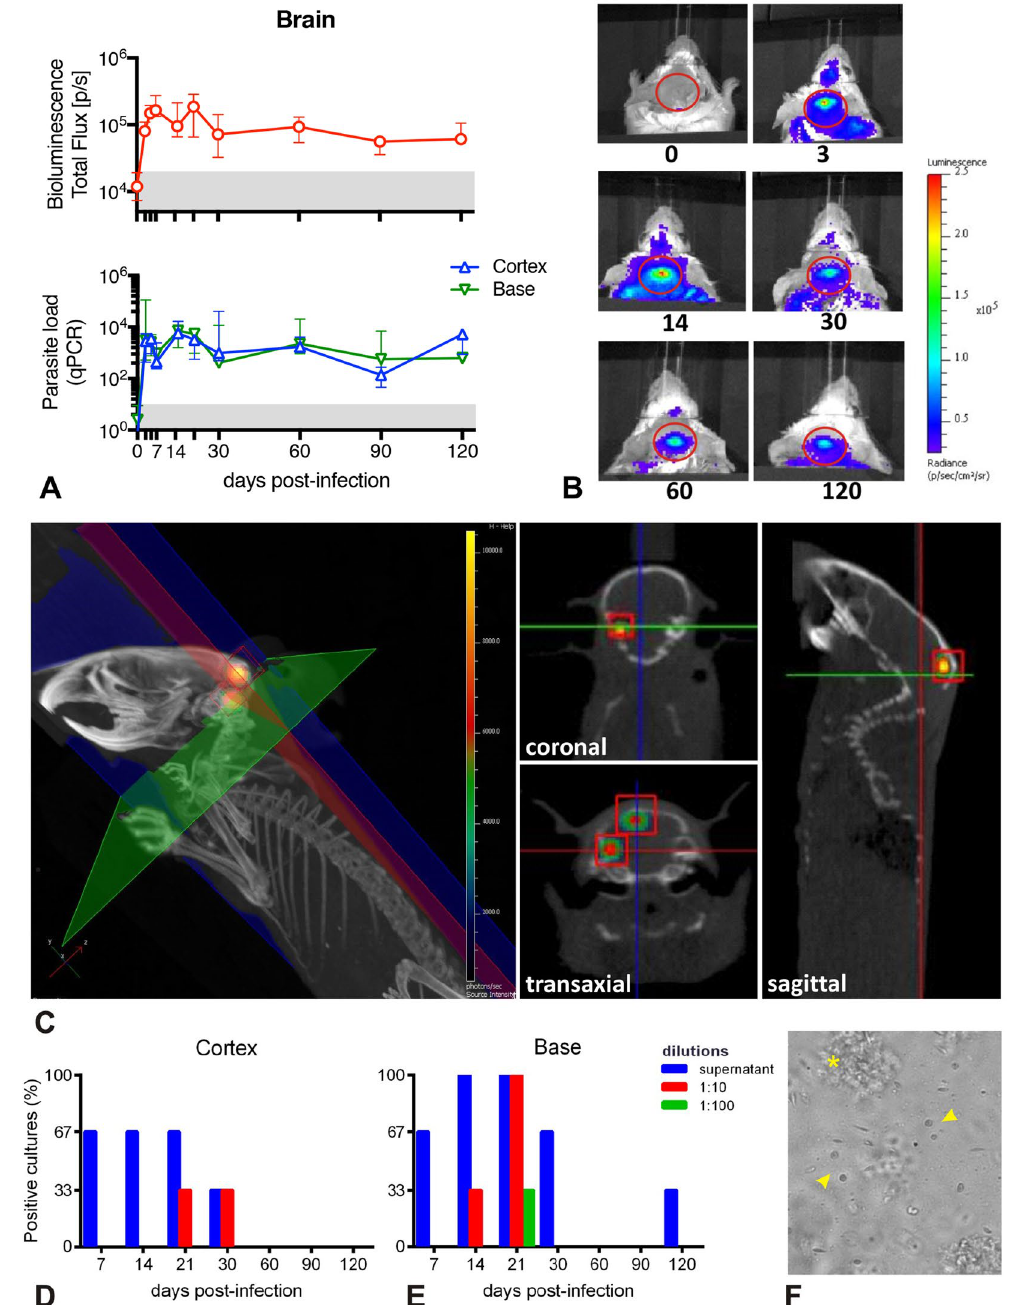
Figure 1. Parasite detection in the brain of BALB/c mice infected with Leishmania donovani . ( A ) Kinetics of the parasite load in the brain detected by bioluminescence (upper panel) and in the cortex and base detected by RT- qPCR (bottom panel). The grey area corresponds to background signals. Data are represented as median and the interquartile range. ( B ) Representative images illustrating the 2D-bioluminescence analysis of the parasite detection in the brain at specific time points post infection. The regions of interest (ROIs) corresponding to the brain are represented as red circles. ( C ) In vivo tridimensional micro-computed tomography to localize the bioluminescence signals within the brain. Representative tridimensional reconstruction of an infected mouse skeleton at 120 days post infection exhibiting the x-axis (blue), y-axis (green) and z-axis (red), and two bioluminescent foci (red cubes). The cross-sectional images exhibit the coronal (z-axis), transaxial (y-axis) and sagittal (x-axis) views and allow the localization of both bioluminescent foci within the cranial cavity (red squares). See also Movie S1. ( D , E ) Parasite isolation from brain tissue. Percentage of positive parasite cultures from the cortex ( D ) and from the base ( E ) of infected BALB/c mice brains, according to different dilutions and time points (n = 3/time point). ( F ) Representative image of a parasite culture from a cortex at day 7 post infection, where it is possible to observe Leishmania donovani promastigotes with different morphologies (arrowhead) surrounded by cellular debris ( *